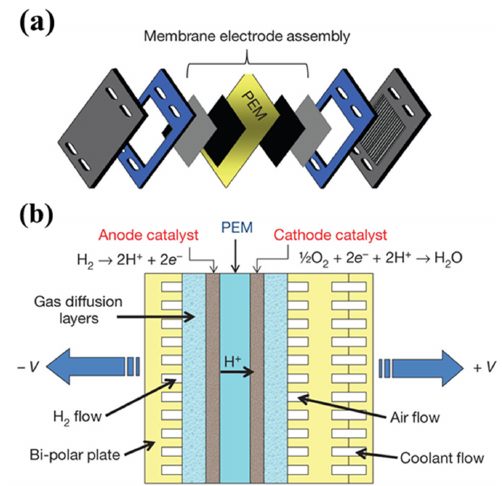
Figure 1. ( a ) Composition structure and ( b ) operational principle of PEMFC. Reprinted with per- mission from Ref. [13]. Copyright 2012, Springer Nature.